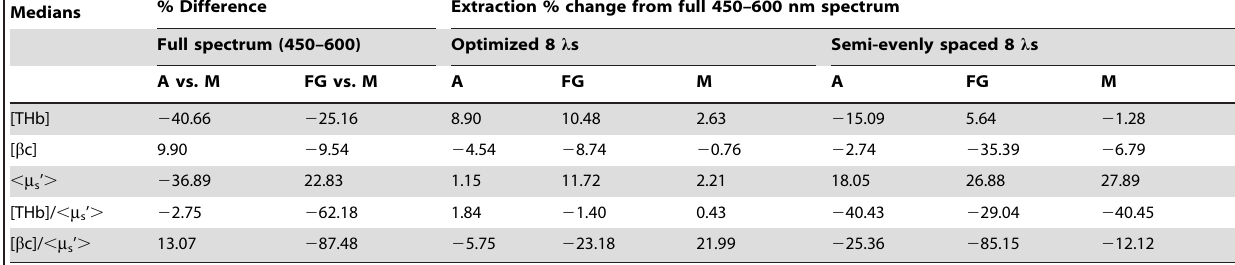
Table 6. Comparison of the percent difference between median adipose and malignant tissue and fibroglandular and malignant tissue to the percent change of extractions using the optimized wavelengths and evenly spaced wavelengths to the full 450– 600 nm